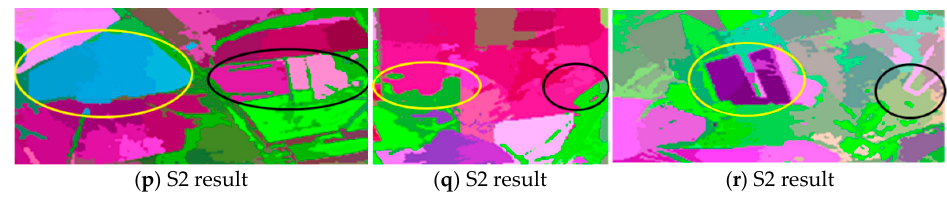
Figure 13. The SLIC segmentation results of three comparison strategies for T3. In terms of the first column of Figure 13, the strategy of S1 could modify the incom- plete superpixels of border areas well as shown in the yellow and black circles, and the superpixels were similar to the reference ones. The strategy of S2 could modify the incom- plete superpixels well as shown in the black circle, while the superpixels in the yellow circle were still incomplete. In terms of the second column of Figure 13, both S1 and S2 could modify the incomplete superpixels of border areas of adjacent tile, but they were not so similar with the reference ones. In terms of the last column of Figure 13, the incom- plete superpixels in both circles could be modified by S1, but S2 split the cropland into two parts in the yellow circle and generated the incomplete superpixels in the black circle.